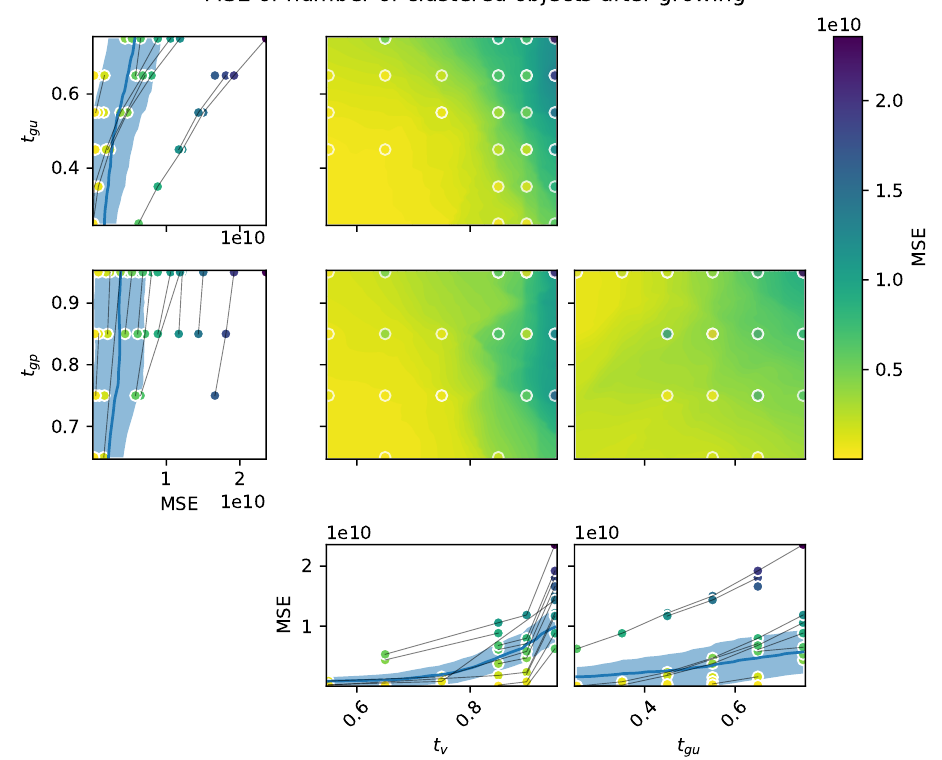
Figure A2. MSE of the number of grown objects as a function of the simulation hyperparameters after one step of the simulation. It mainly depends on the validation threshold t v and the unpure page threshold t gu .